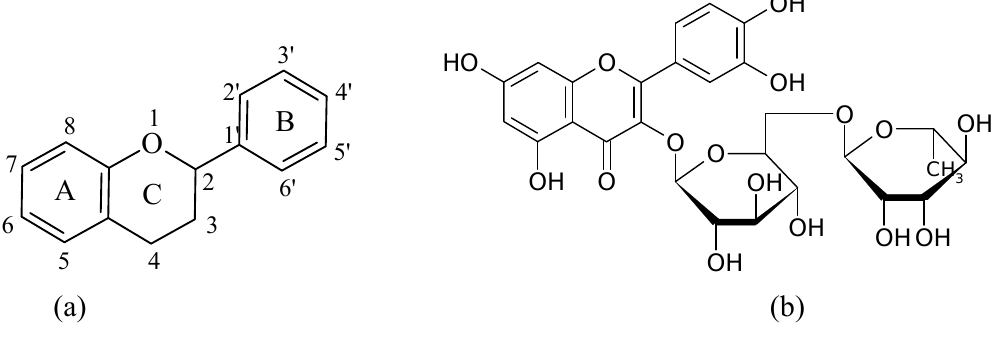
Figure 1. (a) Base structure of flavonoids. (b) Structure of rutin, a flavonol